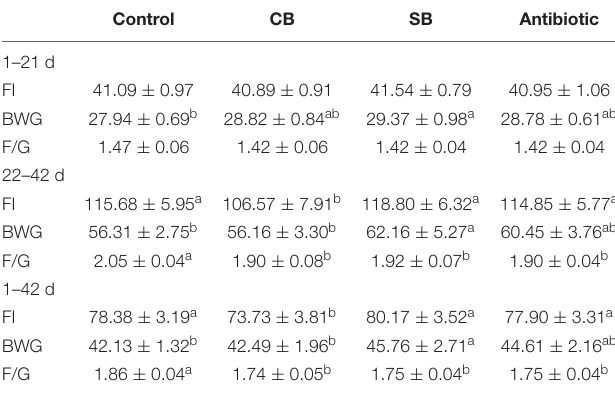
TABLE 3 | Effects of diet on the growth of